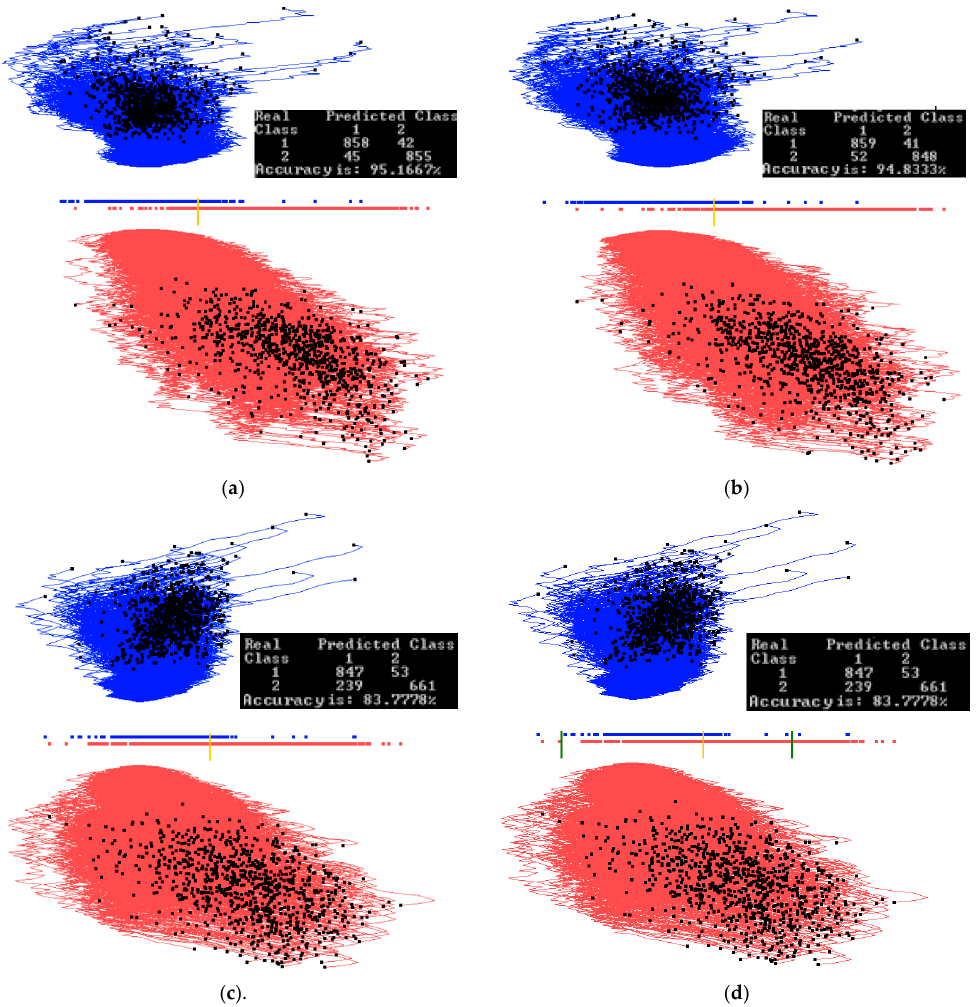
Figure 15. Experiments with 900 samples of MNIST dataset for digits 0 and 1. ( a ) Results for the best linear discriminant function of the first run of 20 epochs; ( b ) Results of the automatic dimension reduction displaying 249 dimensions with 235 dimensions removed with the accuracy dropped by 0.28%; ( c ) Automatic dimension reduction, which is run a few more times removing a total of 393 dimensions and keeping 91 dimensions with dropped accuracy; ( d ) Thresholds for a subinterval are set (green bars).